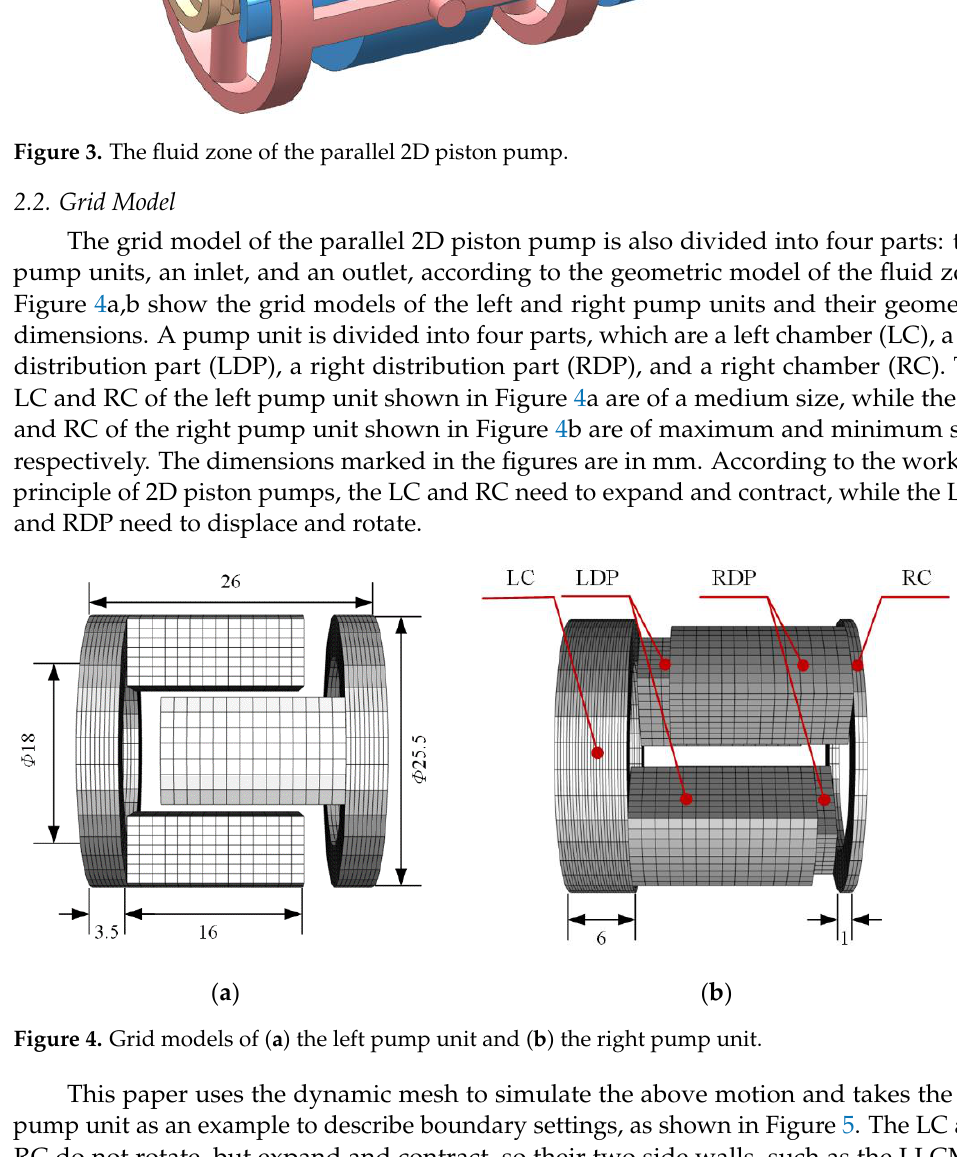
Figure 4. Grid models of ( a ) the left pump unit and ( b ) the right pump unit.